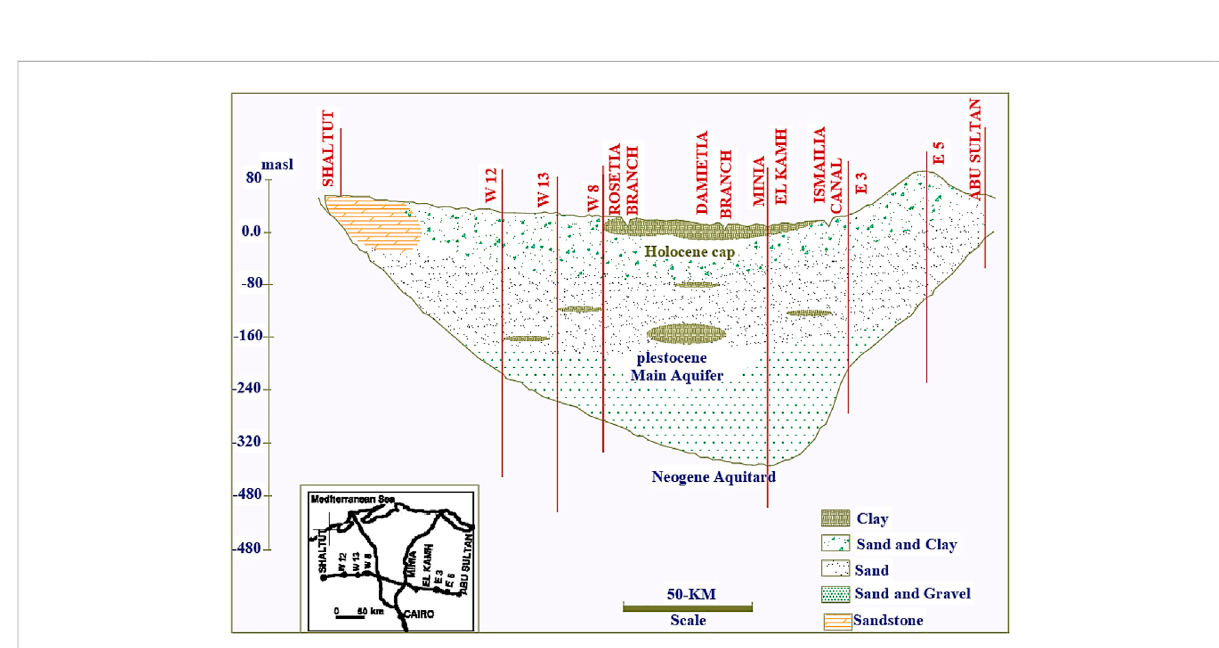
FIGURE 2 Regional hydrogeologic cross-section illustrating the main aquifer of the Nile Delta after Ghodeif et al.